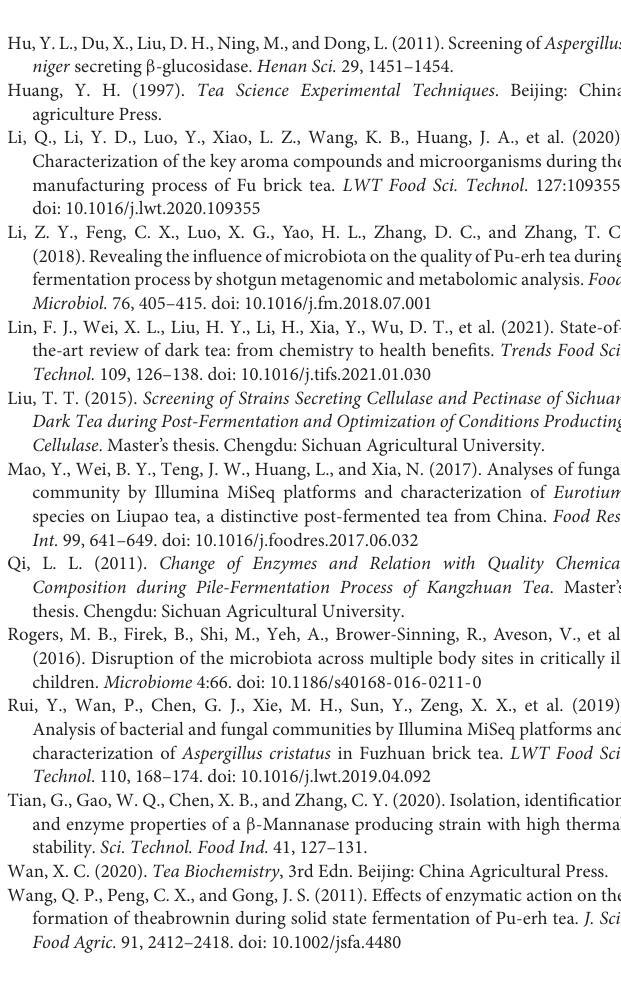
Supplementary Figure 1 | Sichuan South-road Dark Tea. Supplementary Figure 2 | Sampling schematic diagram and Aspergillus niger M10 strain isolated from SSDTX. (A) Sampling point. (B) Morphological characteristics of Aspergillus niger